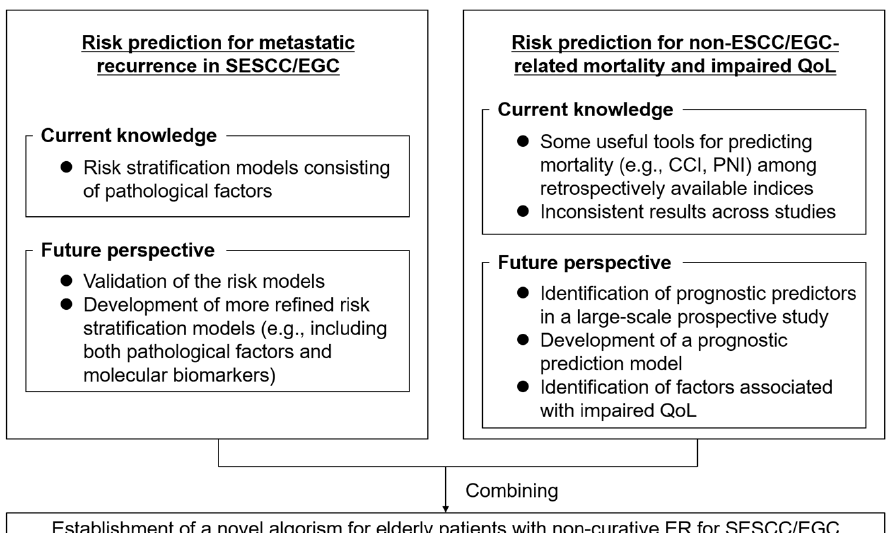
Figure 3. Current knowledge and future perspective for establishing a novel algorithm for older patients with non-curative ER for SESCC or EGC. CCI, Charlson comorbidity index; EGC, early gastric cancer; ER, endoscopic resection; ESCC, esophageal squamous cell carcinoma; PNI, prognostic nutrition index; QoL, quality of life; SESCC, superficial esophageal squamous cell carcinoma.